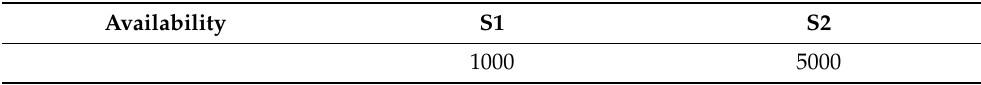
Table 2. Total availability of products at the supplier points.